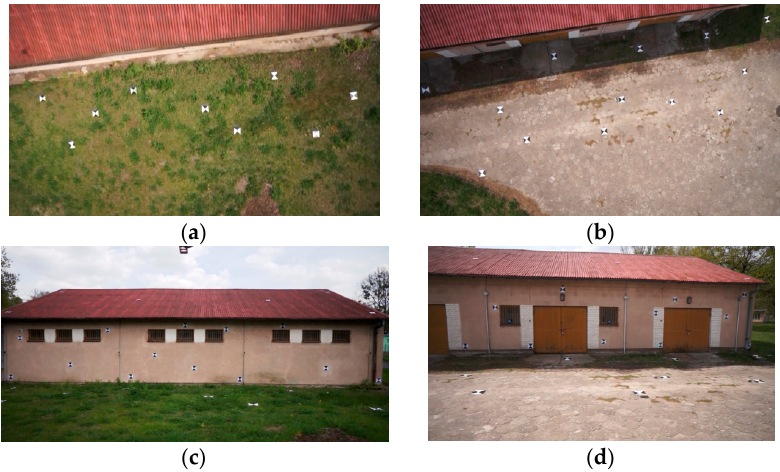
Figure 8. Example pairs of images from the terrestrial and aerial orientations: NE wall ( a , b ); SW wall ( c , d ) wall ( c , d ).